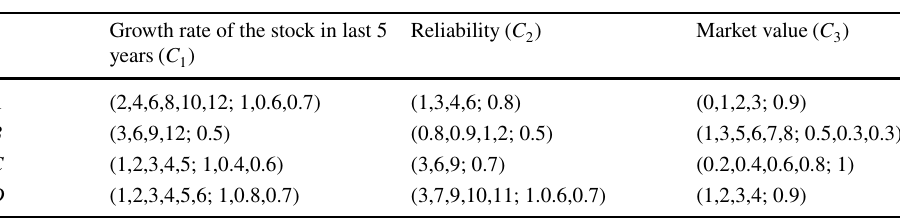
Table 1 MCDM data matrix